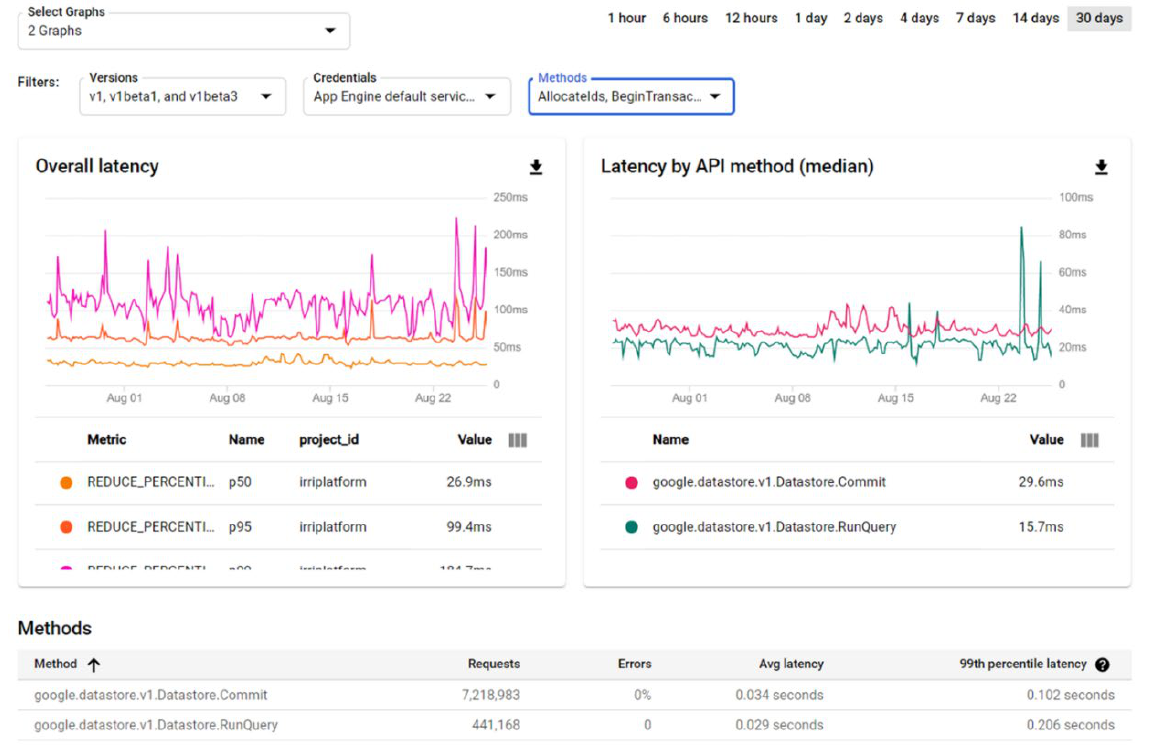
Figure 14. Results for latency when the requests to Commit and RunQuery methods are carried out.